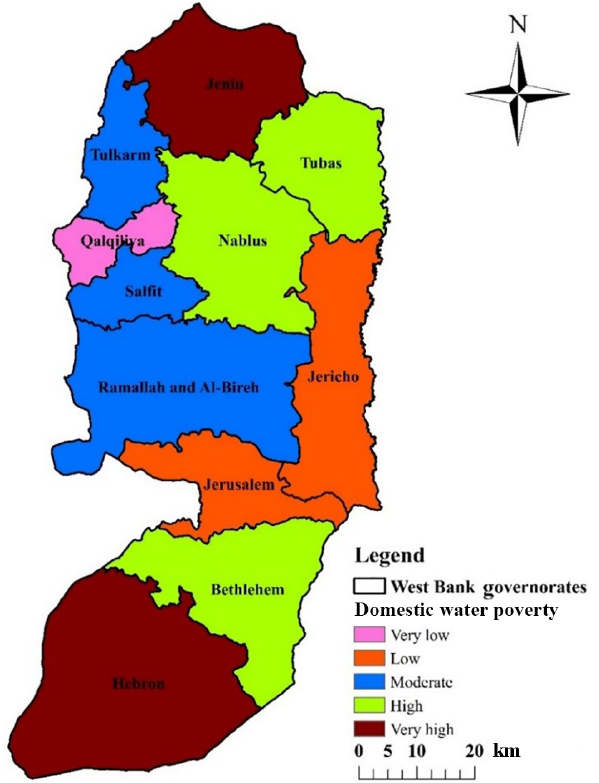
Figure 7. DRWHS map for the West